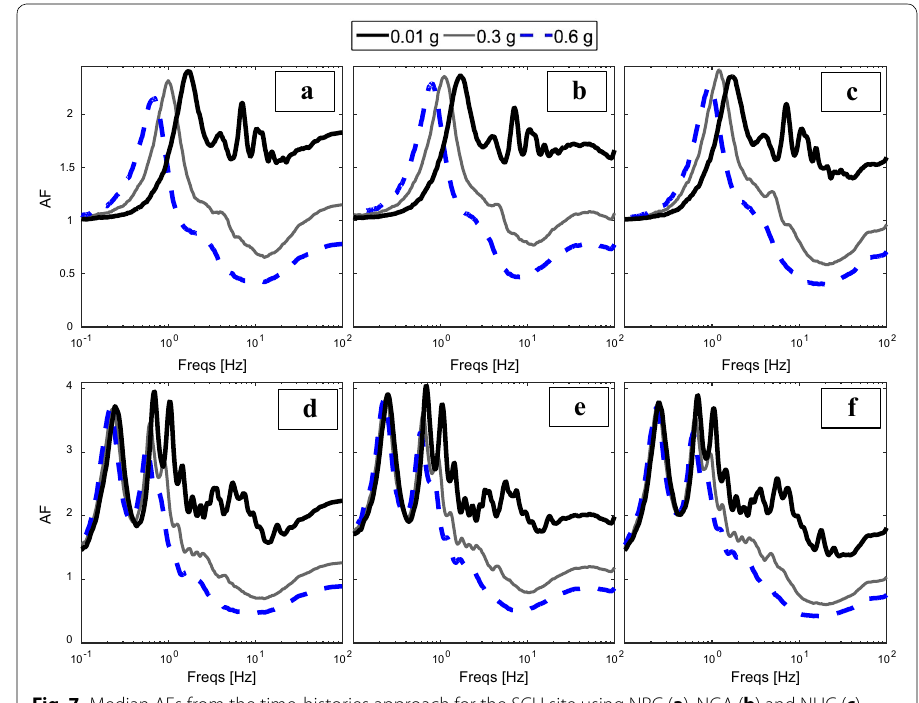
Fig. 7 Median AFs from the time‑histories approach for the SCH site using NRC ( a ), NGA ( b ) and NUC ( c ) spectra; and for the CC site using NRC ( d ), NGA ( e ) and NUC ( f )